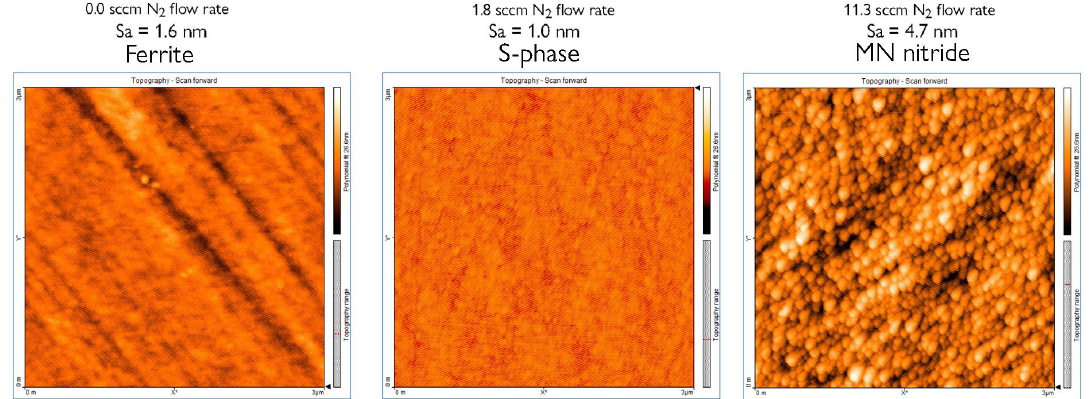
Figure 4. Sample surface appearance, as observed in the AFM facility for films with different Table 1. Effects of sputtering conditions on XRD-accessed phase fractions, WDS-accessed average N-content, film hardness, and film elastic modulus. N flow rate, Sputtering conditions 2 sccm